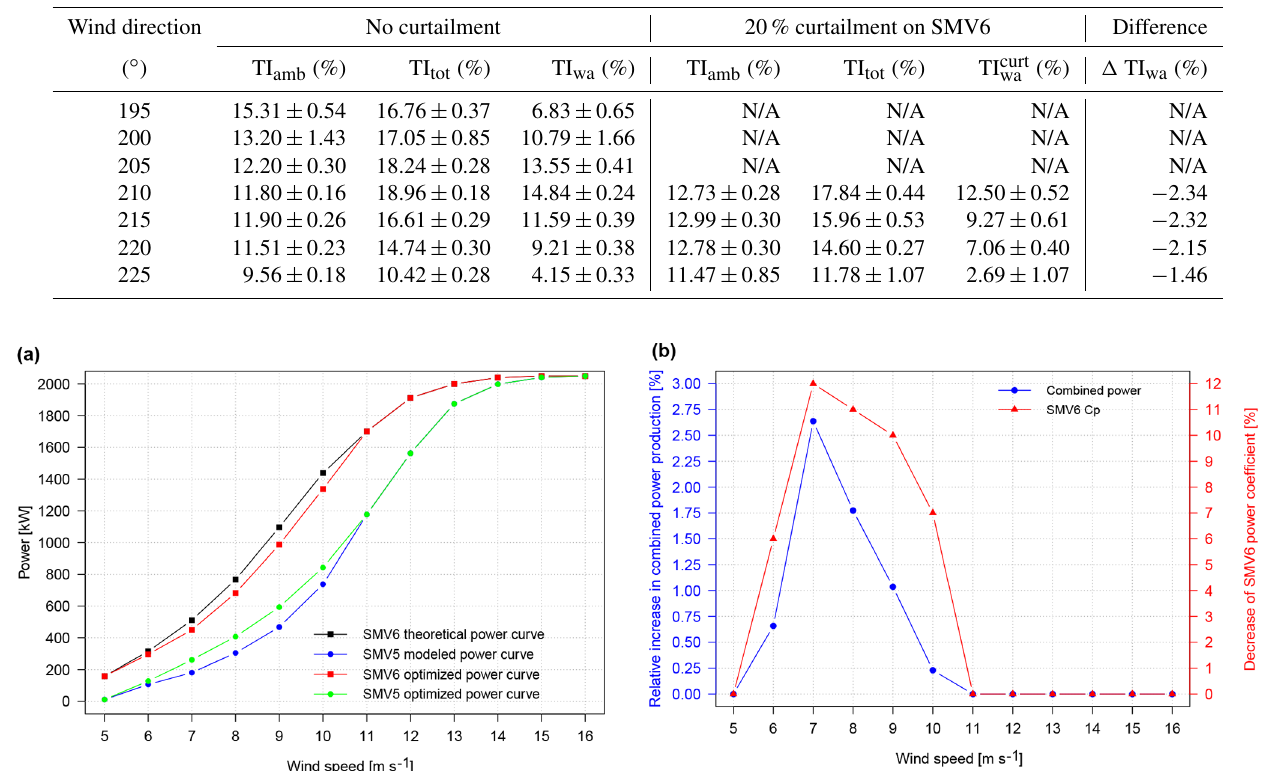
Figure 11. Optimization of power production of SMV6 and SMV5. Power curves in the base and optimized cases (a) and variation of power gain and optimal SMV6 c P as a function of wind speed for the optimized case (b)